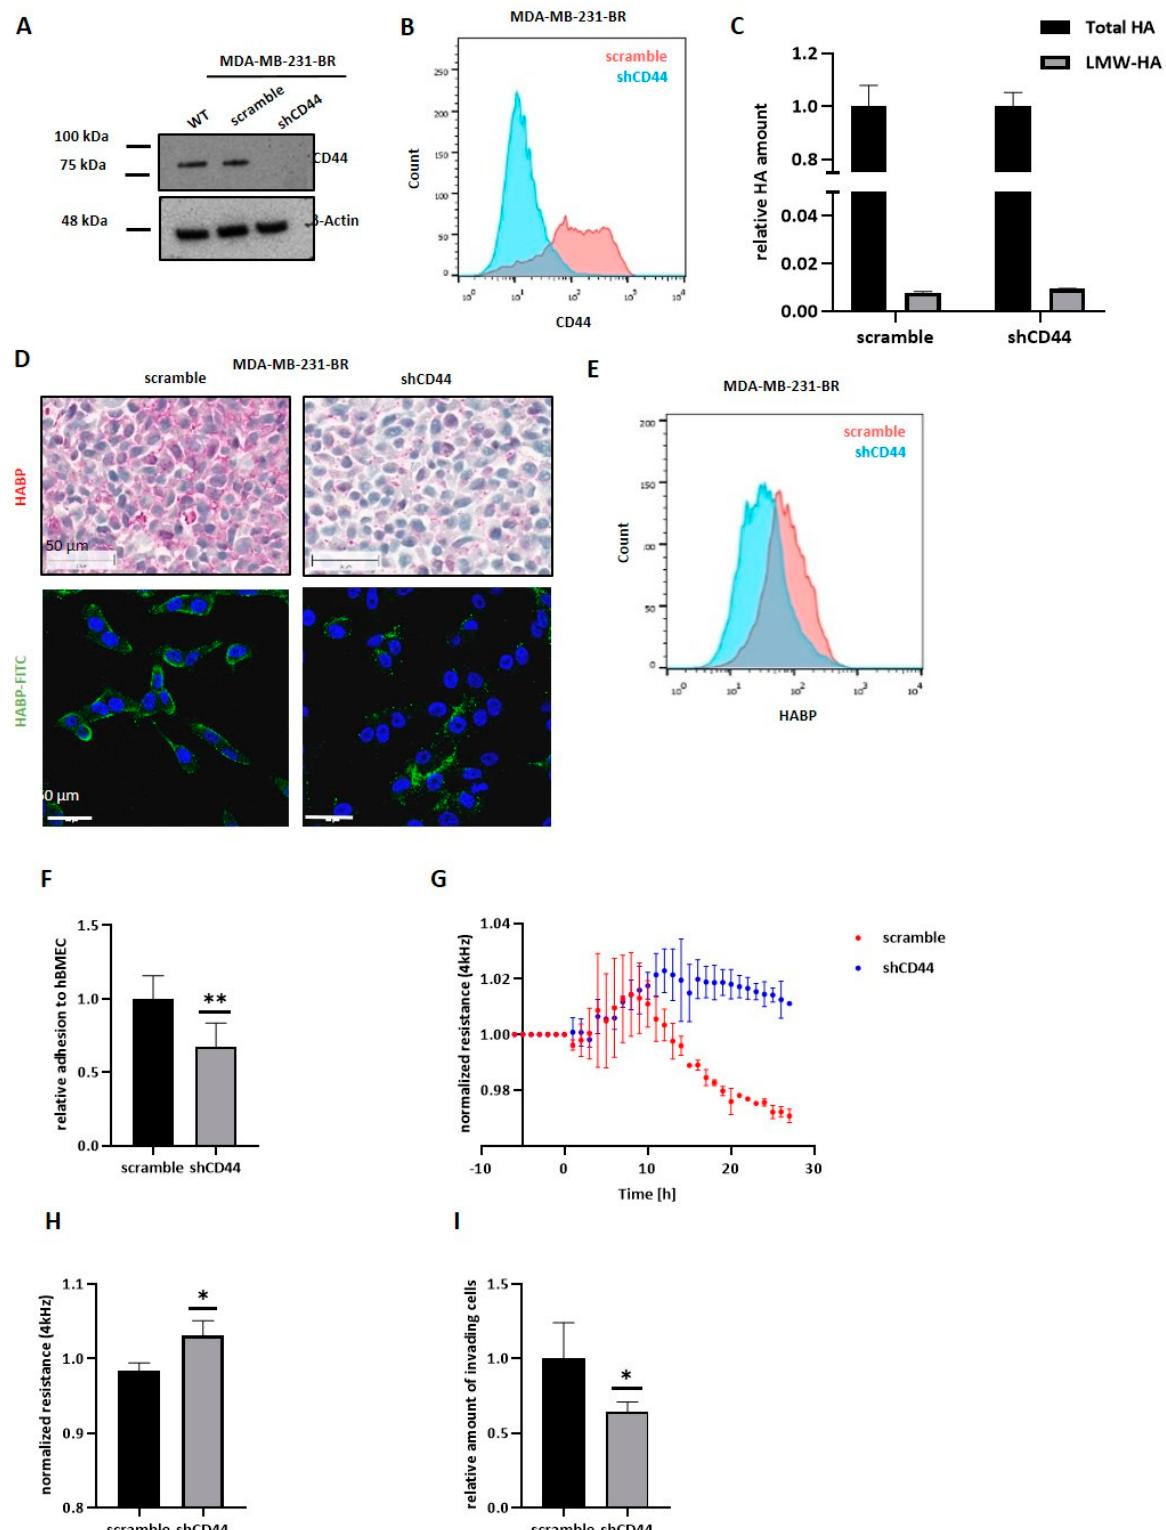
Figure 7. CD44 knockdown in MDA-MB-231-BR and its impact on HA metabolism and interaction with the BBB. ( A ) Representative Western blot ( n = 2) result of protein lysates (20 µg) of MDA-MB-231-BR WT, control (scramble), and CD44